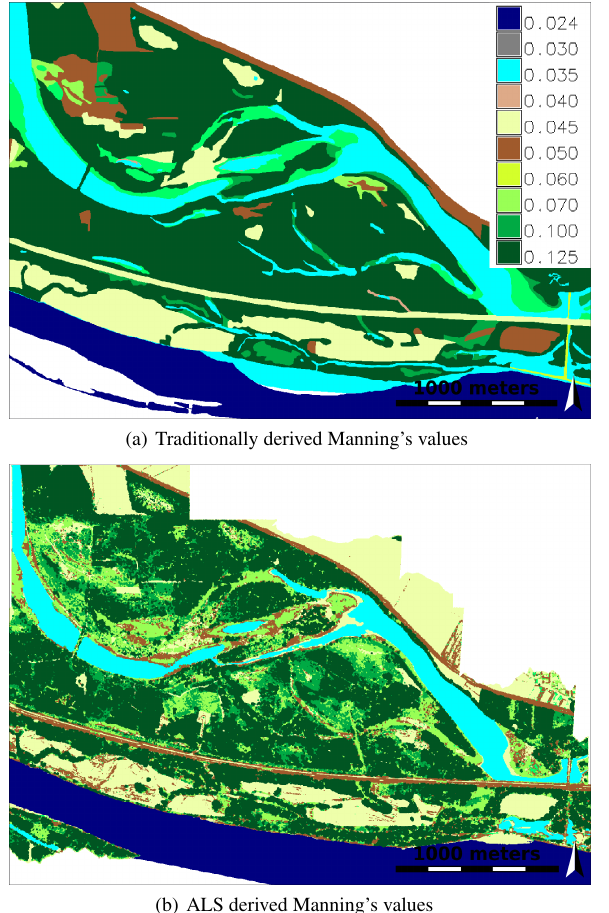
Figure 3: Traditionally derived Manning’s values vs. the ALS derived values [ s/m 1 / 3 ]